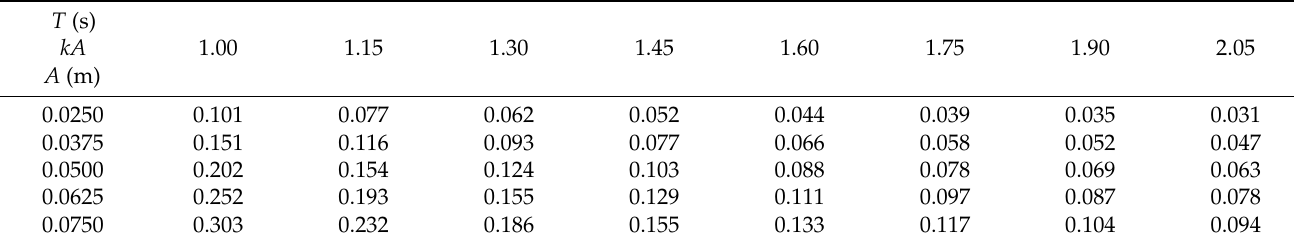
Table 2. Tested wave